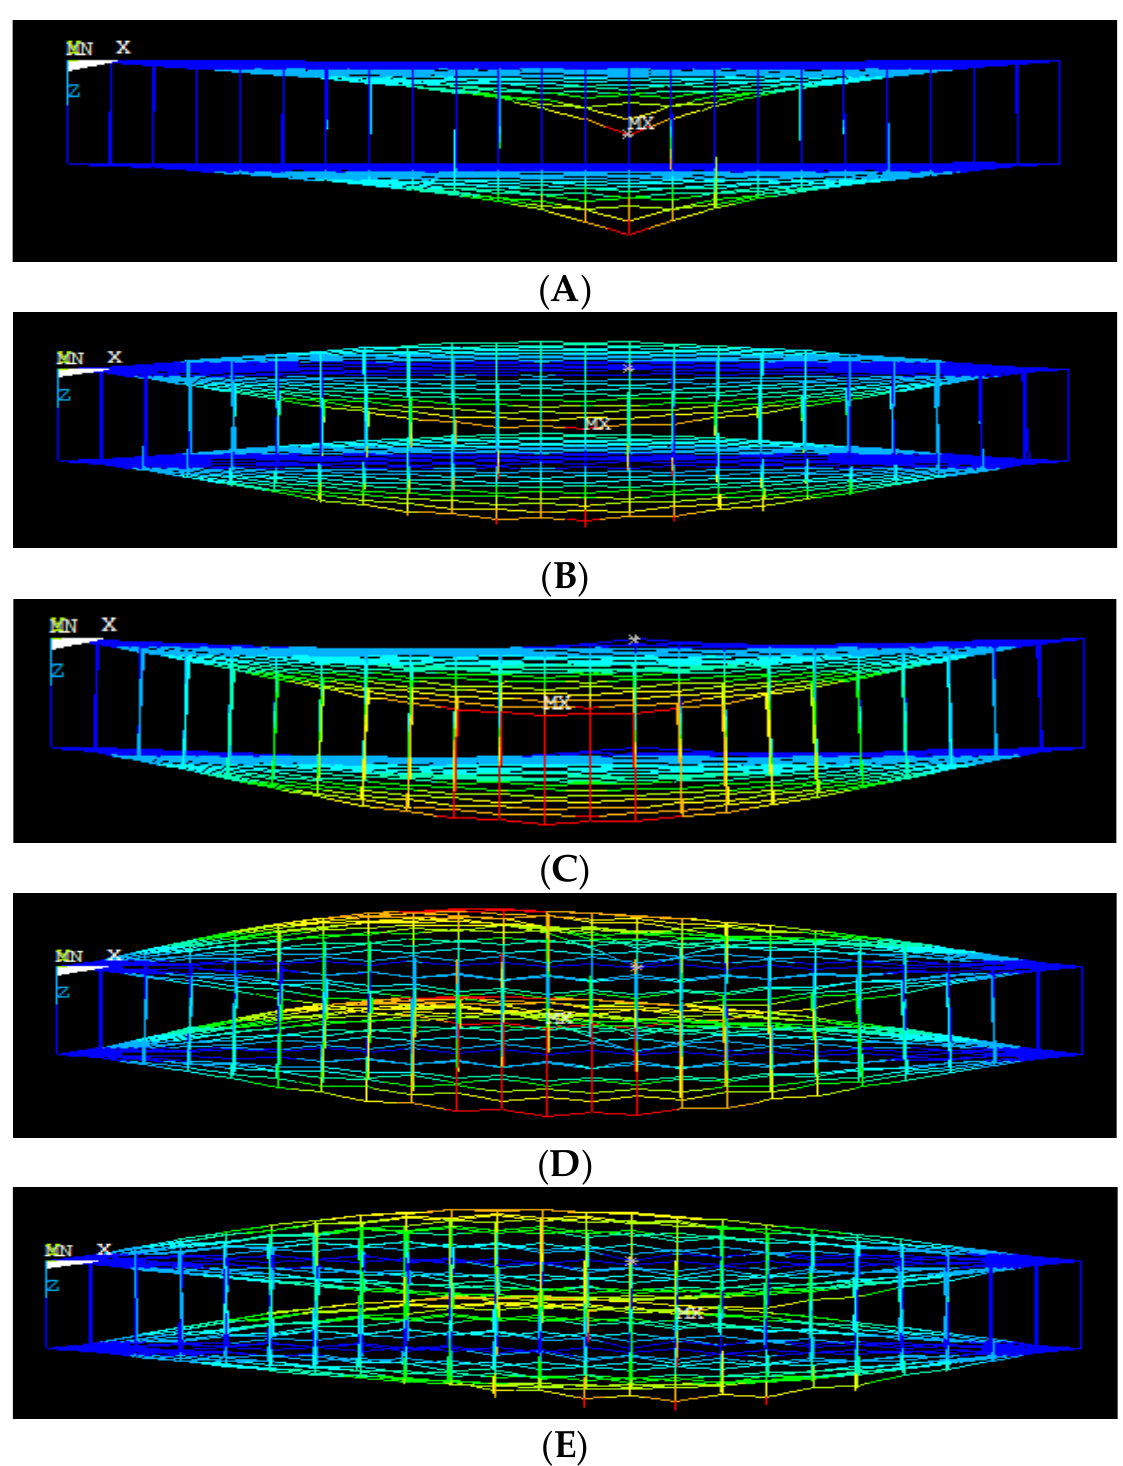
Figure 16. ( A – E ) Different mode shapes of bridged DLG (20, 0) with length 50 nm (front view of mode